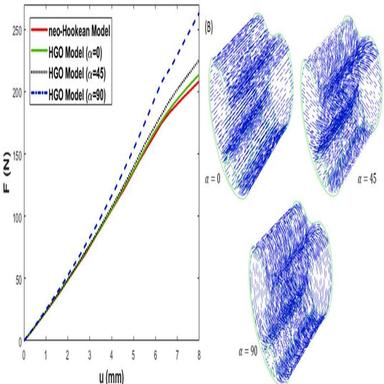
(A) Influence of fibre orientation in TA on the overall response of penile tissue in compression testing (d = 0). (B) Different fibre orientations in TA.